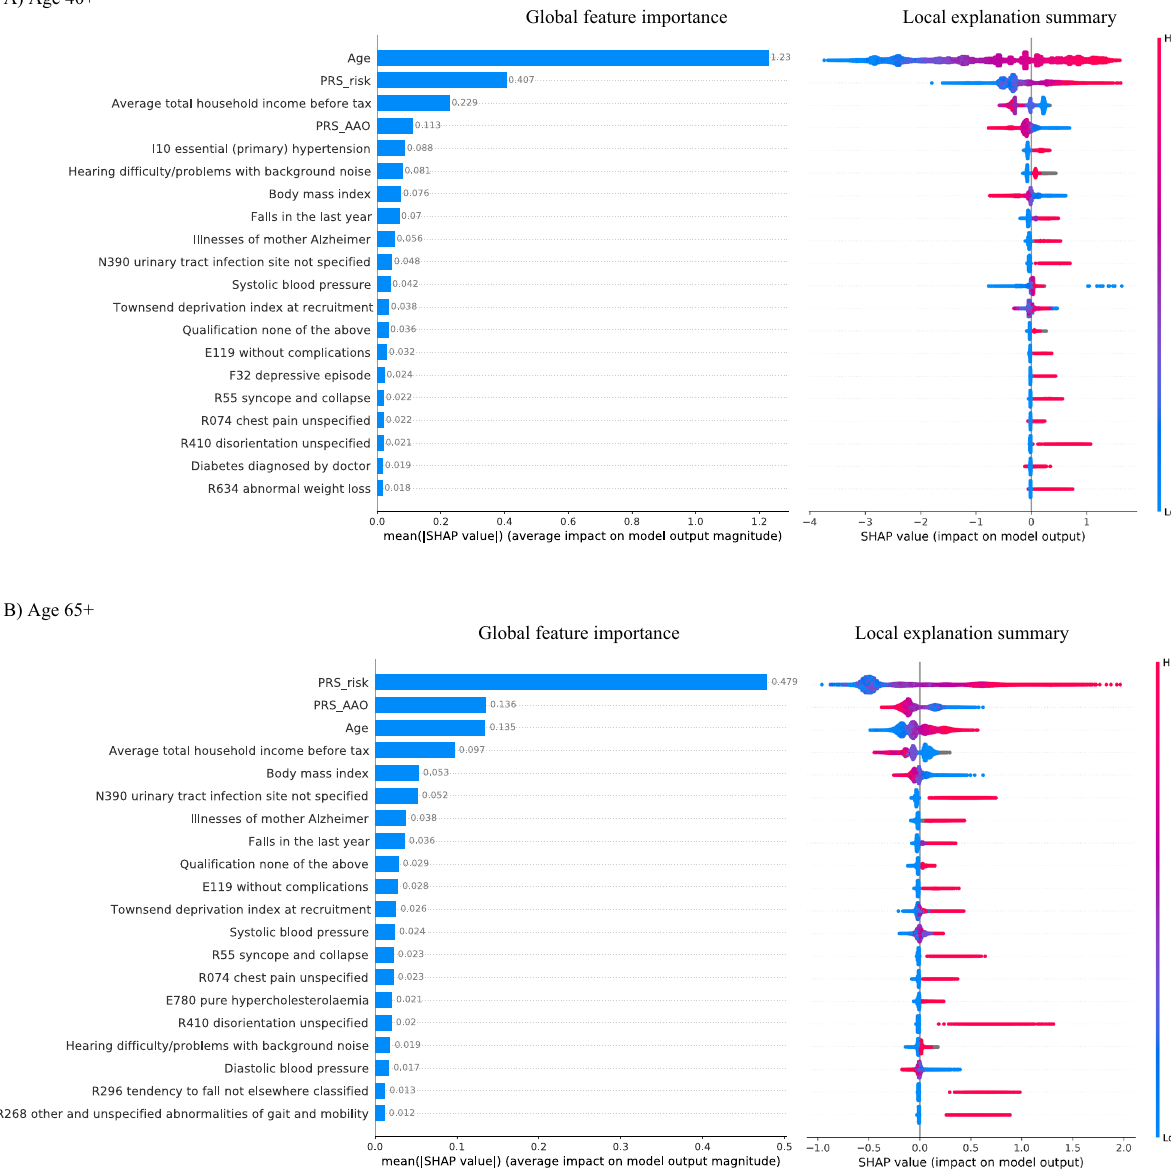
Figure 2. Feature importance and impact of top 20 most important features for different age groups. SHAP global feature importance bar chart (left) and SHAP local explanation summary plot (right) for two age groups ( A ) Age 40 + , and ( B ) Age 65 + . Red and blue in the summary plot represent high and low feature values, respectively. The gray numerical values in the left bar plots show the mean (|SHAP value|), which shows the average impact on model output magnitude. The long right tails in the local explanation summary plot indicate rare but large-effect-size risk